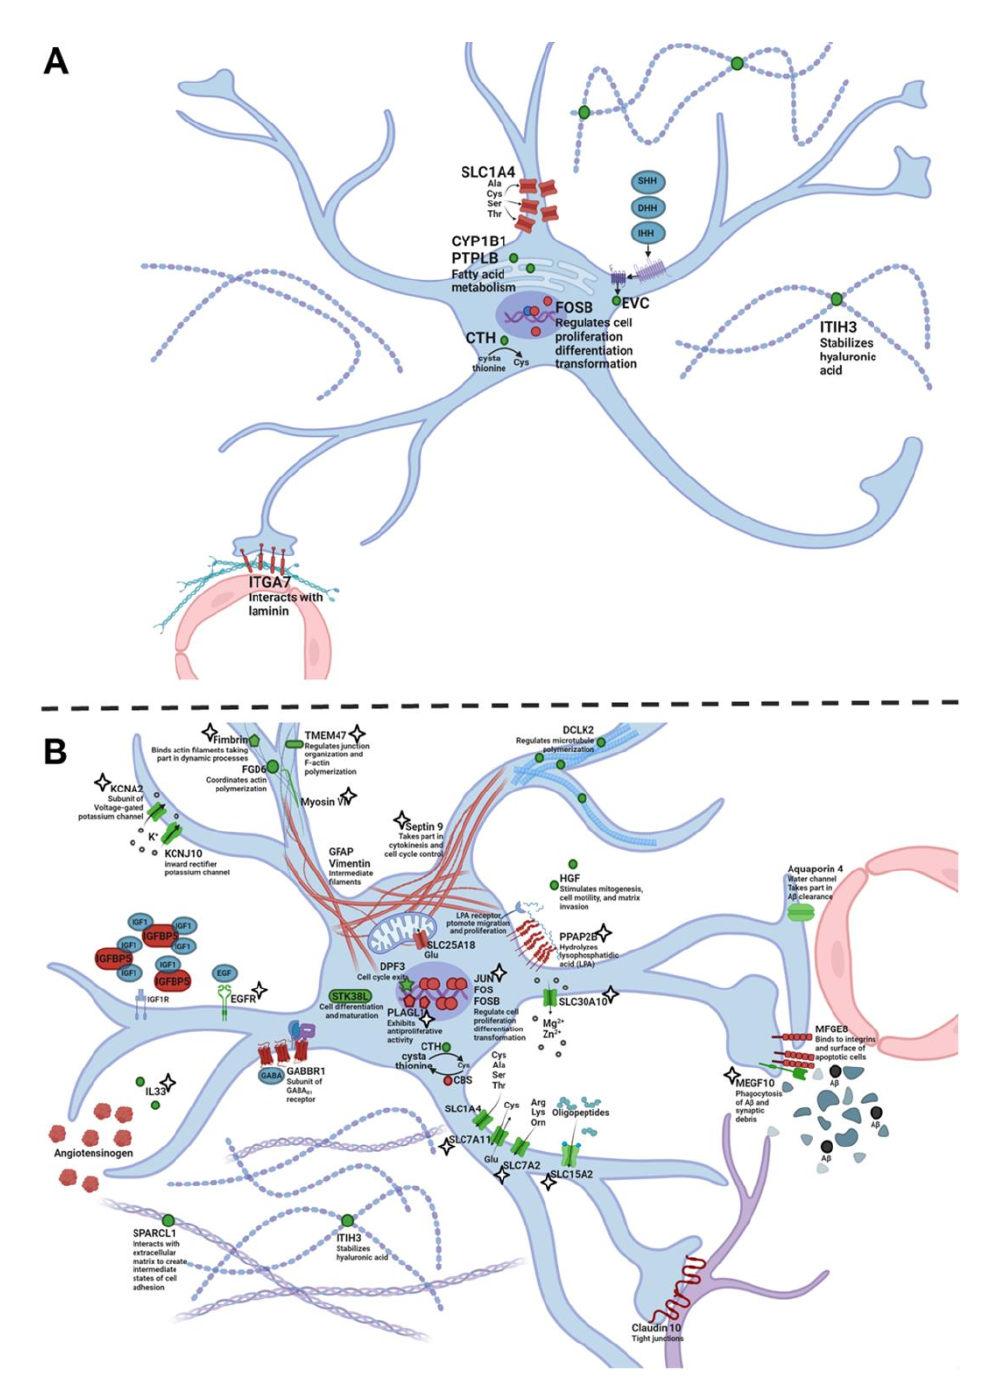
Figure 3. An astrocyte of 5-month-old ( A ) and 18-month-old ( B ) OXYS rats. Proteins with decreased gene expression—as compared to Wistar rats or to previous age—are highlighted in green; proteins with increased gene expression are red. Stars ( B ) indicate the genes whose expression was altered by SkQ1. The illustration was created on BioRender.com (accessed on 15 November